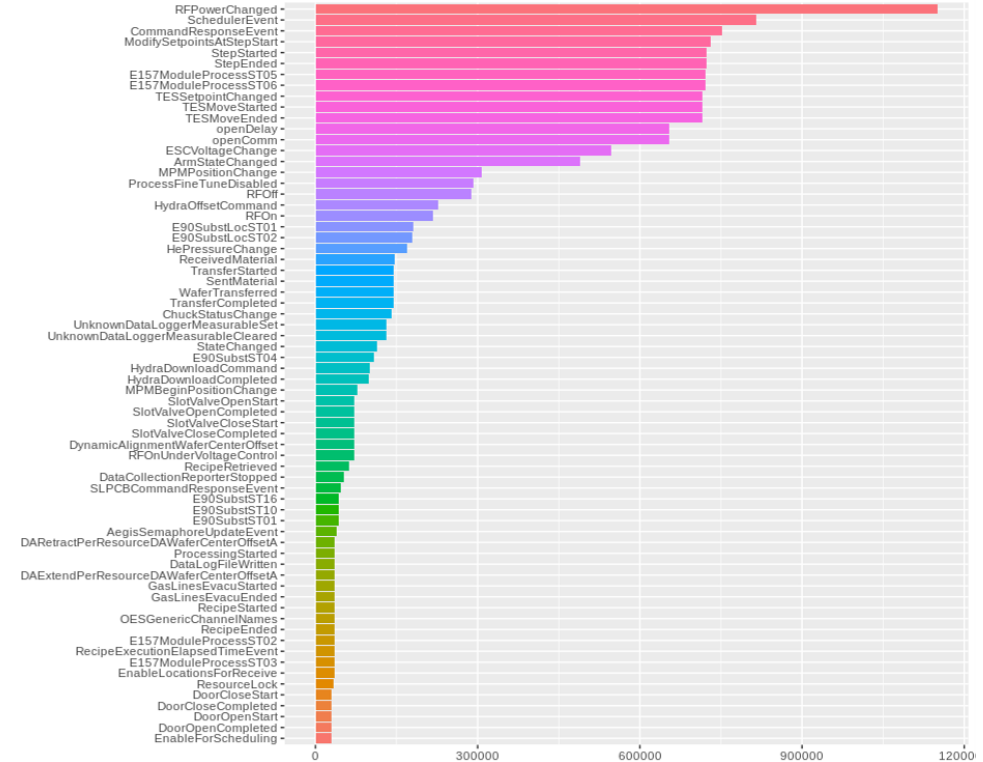
Figure 8. Event Occurrence Frequency by